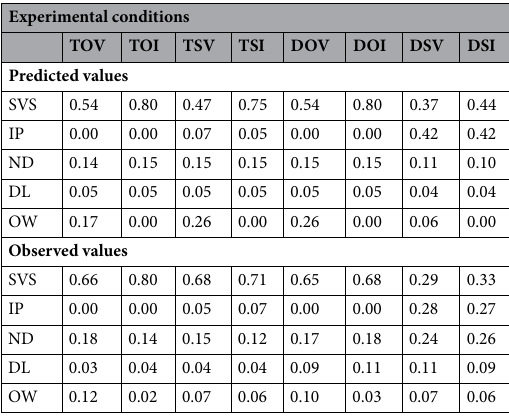
Table 7. Predicted and experimentally observed fixation probabilities of each AOI in the eight experimental conditions.